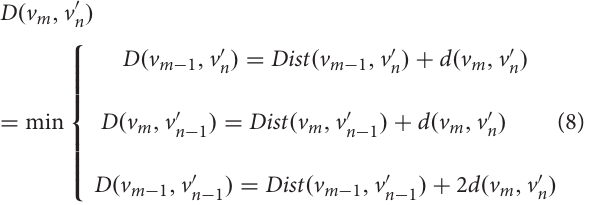
Protein Similarity